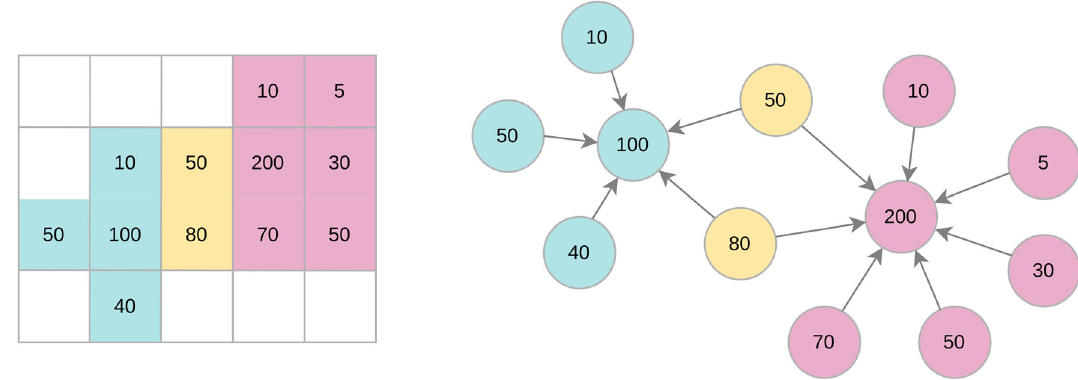
Fig. 2 An example of two clusters with overlapping cells on the calorimeter on the left and its graph representation on the right